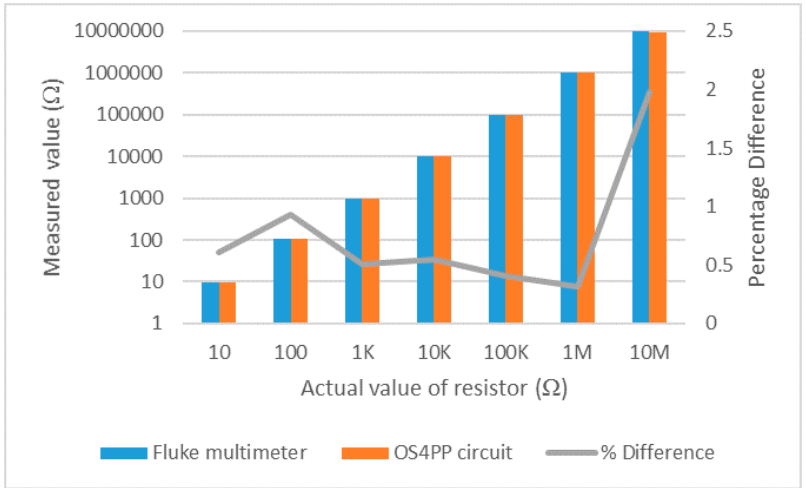
Figure 12. Comparison of measurement results on discrete resistor.